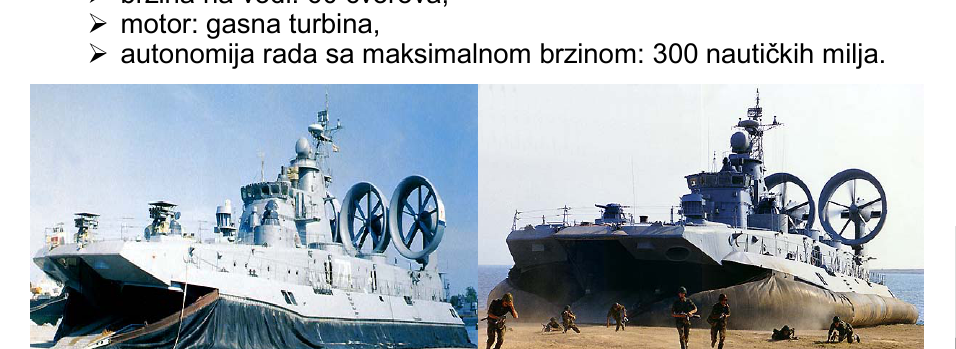
Slika 18 – Lebdelica „Pomornik” Figure 18 – Hovercraft „Pomornik Amfibijska sredstva oružanih snaga Narodne Republike